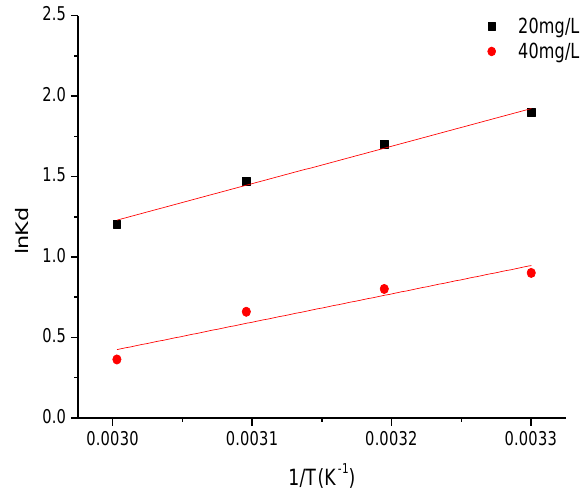
Figure 9. Liner plot of lnK d versus 1/T for the adsorption of MB.